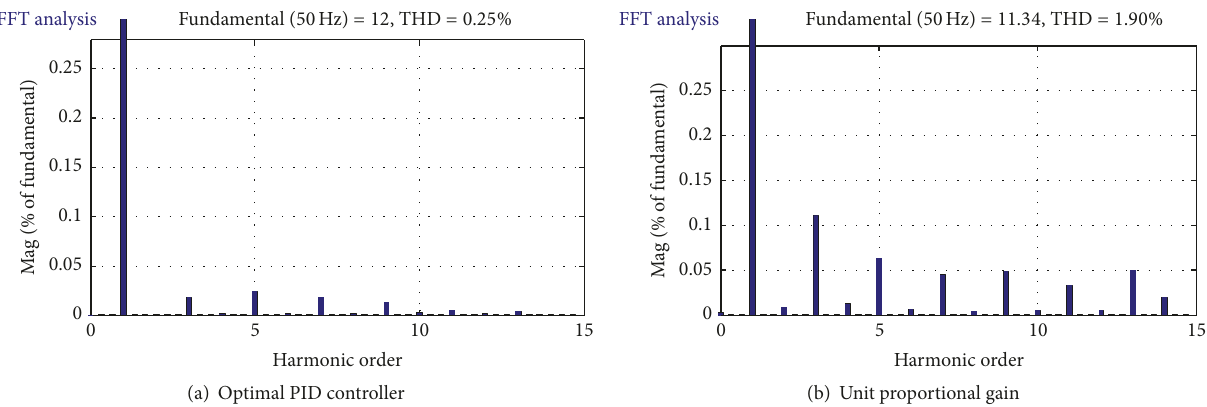
Figure 11: FFT analysis of the output current of the grid connected inverter and its frequency spectrum as in (a) and (b).